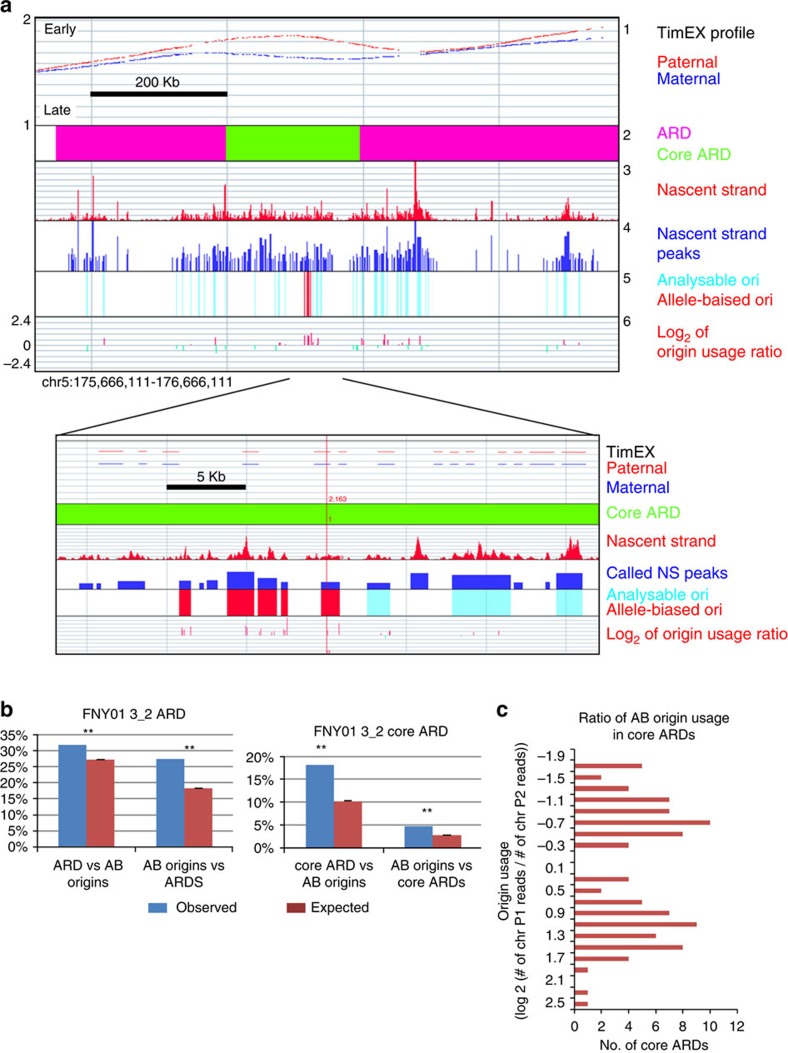
Asynchronously replicated regions (ARDs) are enriched in allele-biased origins of replication.(a) Track 1: timing of replication profile of a genomic region containing a 1-Mb ARD. The blue and red curves, respectively, represent the TimEX profiles of the maternal and paternal chromosomes. The y axis represents the S/G1 TimEX ratio, which is proportional to the replication time during S phase. The TimEX ratio is the ratio of the number of reads observed in the S and G1 phase of the cell cycle and was calculated in 5,000-bp windows genome-wide. Track 2: pink, ARD; green, core ARD. Track 3: NS profile (binned in 10-bp windows). Track 4: NS peaks called by MACS. Track 5: light blue: analysable origins (that is, origins overlapping at least 50 SNP-containing reads); red: allele-biased origins (origins with statistically different number of reads on both alleles (FDR<0.05)). Track 6: log ratio of the number of reads observed in P1 and P2. Zoomed-in region: same as above but magnified 40 times. (b) ARDs and core ARDs are enriched in allele-biased origins of replication. Left histograms: per cent ARDs that contain allele-biased origins. Right histograms: per cent core ARDs that contain allele-biased origins (AB origins). Blue bars, observed values; red bars, expected values. Stars indicate that the differences between observed and expected values were significant (permutation P value <0.001). Expected values and P values were calculated by performing 10,000 permutations. Error bars represents s.e.m of permutations. (c) Histogram illustrating the distribution of allele bias in origins located within core ARDs. x axis, number of core ARDs; y axis=log2(number of reads on chr P1/number of reads on chr P2).